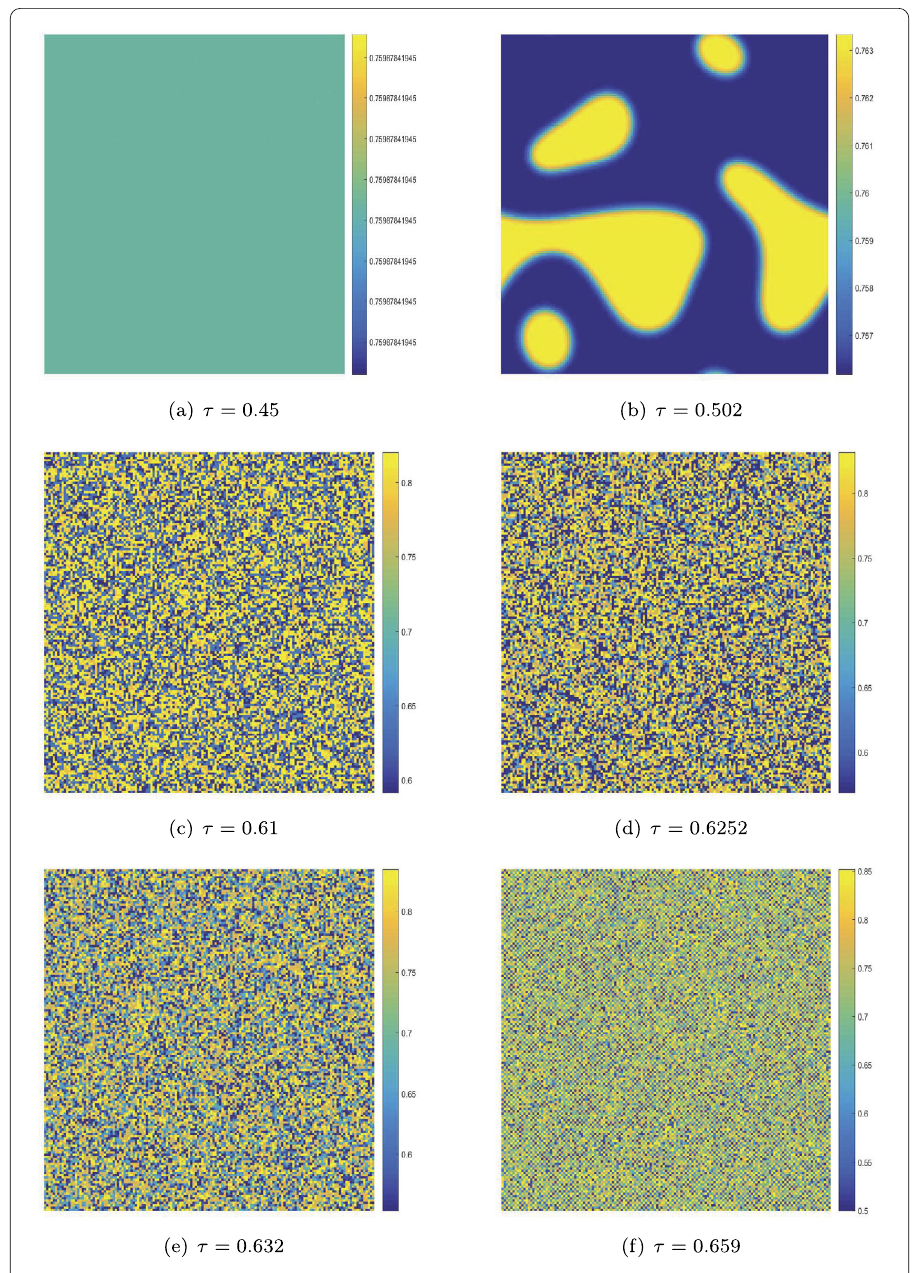
Figure 6 Spatial patterns of re-scaled wrack biomass W self-organized under pure-Turing instability, flip-Turing instability, and chaos on 150 × 150 lattices